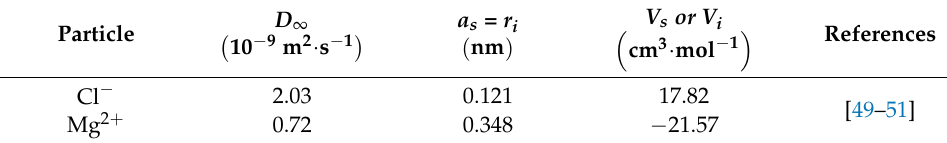
Table 3. Stokes radii, partial molar volumes, and diffusivities of solute particles.